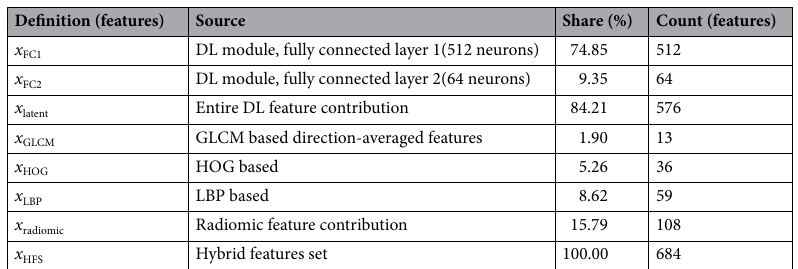
Table 14. Features forming HFS for radiogenomic classification using the BraTS-2021